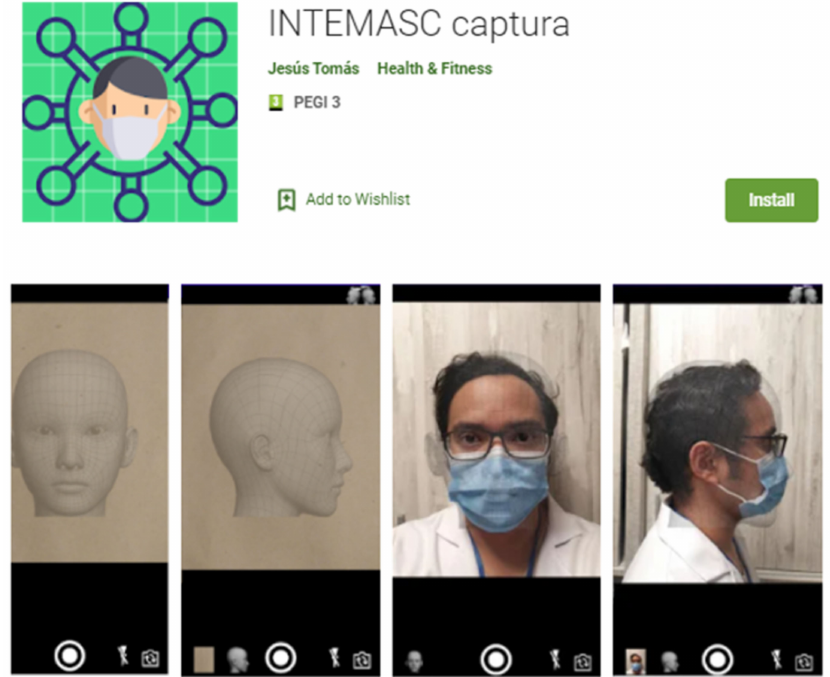
Figure 1. Application in Google Play for the acquisition of the training